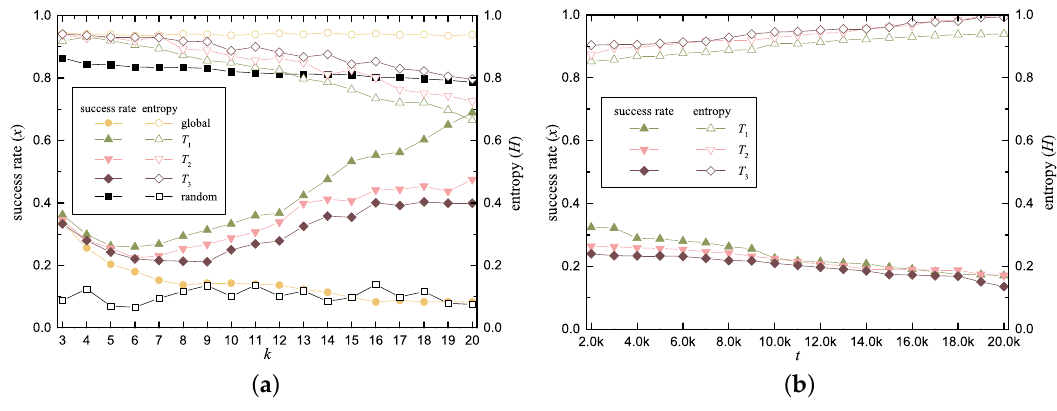
Figure 7. Experiment results of resistance on the statistical inference attack. ( a ) x and H vs. k with the initial M ; ( b ) x and H vs. t with the dynamic M